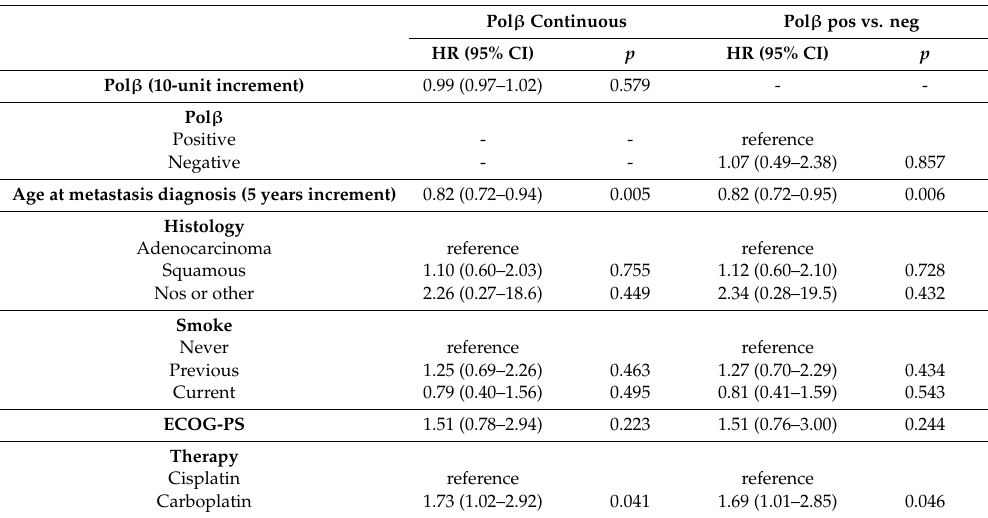
Table 2. Multivariable Cox models adjusted for ECOG-PS, age, histology, smoking, and therapy for progression-free survival, considering Pol β continuous or Pol β positive vs. negative. Pos, positive; neg, negative.